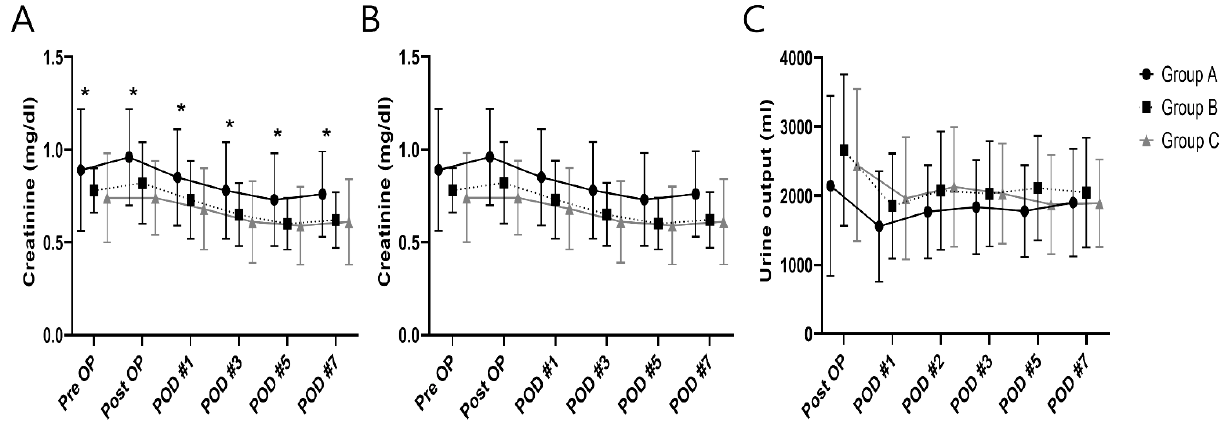
Figure 3. Between-group comparisons in daily serum creatinine ( A ), fluid balances ( B ) and urine outputs ( C ) in the perioperative period. * p < 0.05.